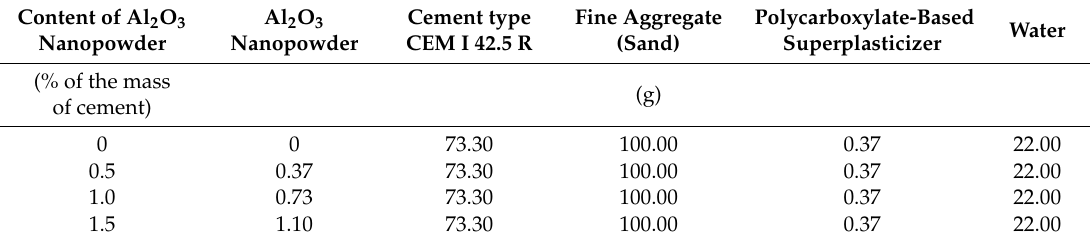
Table 1. Mix designs of cement mortars used to make the overlays with the addition of aluminum oxide (Al 2 O 3 ) nanopowder (per 100 g of sand). Content of Al 2 O 3